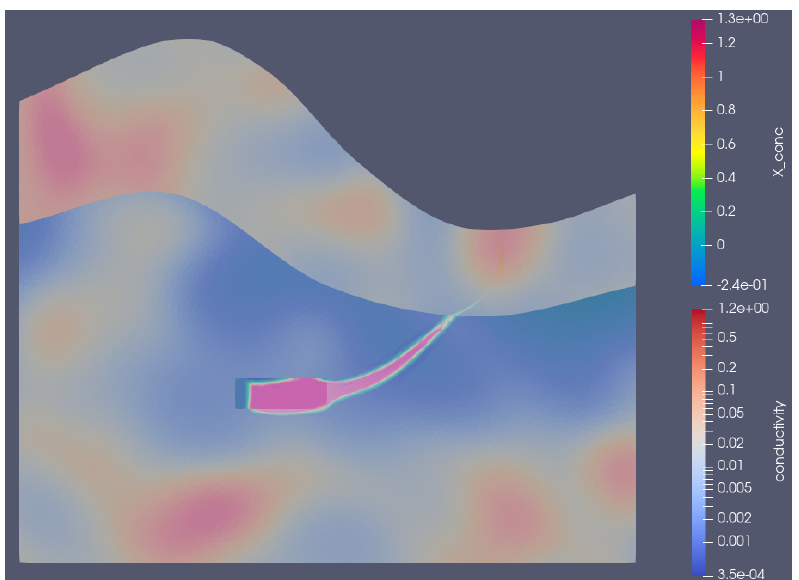
Figure 1. Contaminant transport problem. A high concentration (X_conc) of a contaminant is spreading from the DGR to the surface. Its course is influenced by the depicted hydraulic conductivity (conductivity) of the rock